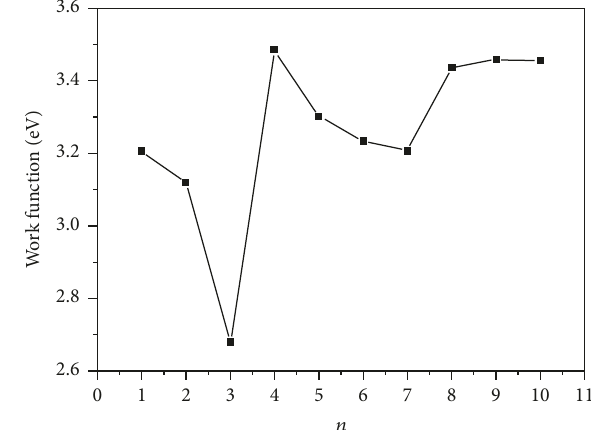
Figure 4: Variation of surface energies of U(001) slabs as a function slab thickness.